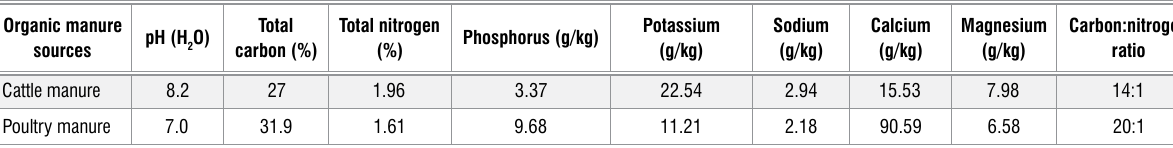
Summary of monthly meteorological data during 2013/2014